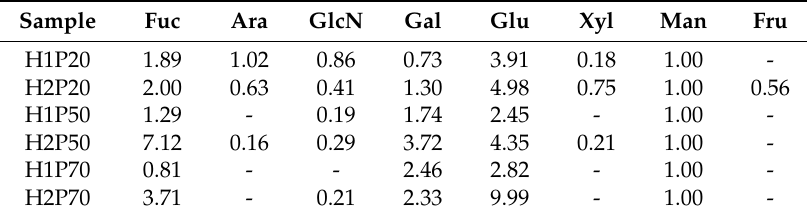
Table 3. Monosaccharide composition of ethanol precipitated